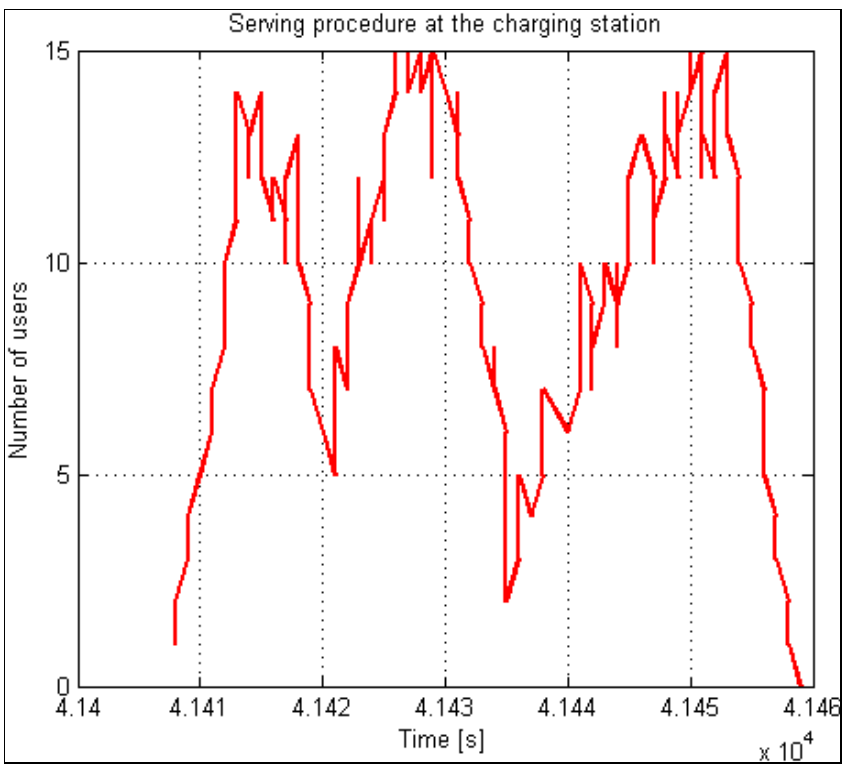
Figure 21. Bursts with an increased number of users influence the formation of a queue.